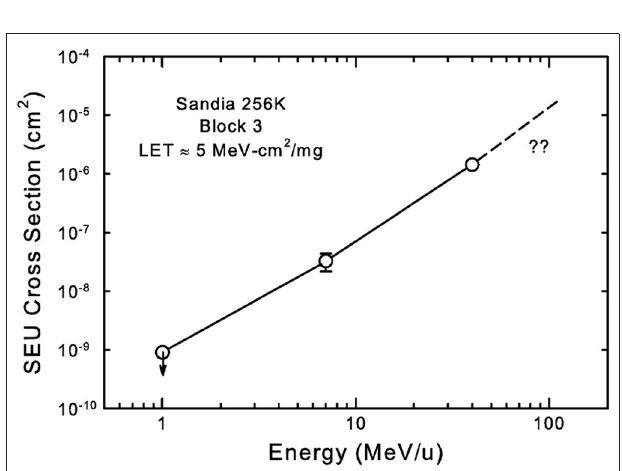
FIGURE 2 | Measured SEU cross section for block 3 of the Sandia 256 kbit SRAM taken with heavy ions having an LET of 5 (MeV cm 2 /mg) as a function of energy [ 12]. Reproduced with permission from IEEE.